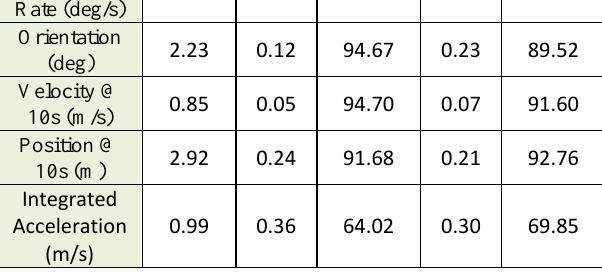
Table 1: RMSE of the input signals and estimated navigation quantities before and after in-situ user self-calibration with and without apply loop-closure to the walking trial (with the IMU near the torso).